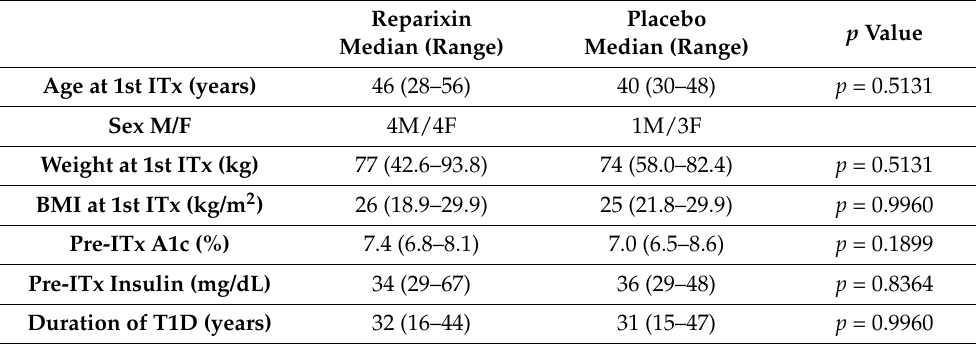
Table 1. Characteristics of islet transplant recipients. Demographic characteristics and disease course of diabetic patients receiving islet allografts with Reparixin or